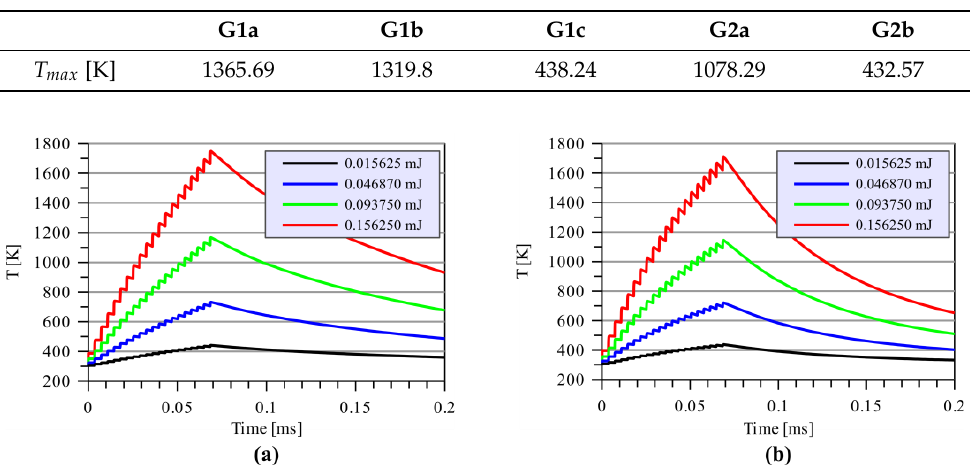
Table 5. Maximum MLL (WC/SiC) temperatures T max for different geometries after 20 XFEL pulses and absorbed energy Q abs = 0.015625 mJ.